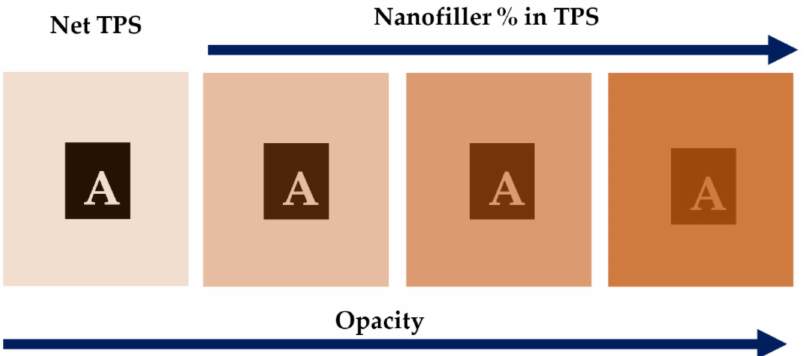
Figure 10. Schematic representation of opacity from net TPS to an increasing percentage of nanofiller in TPS nanocomposite.